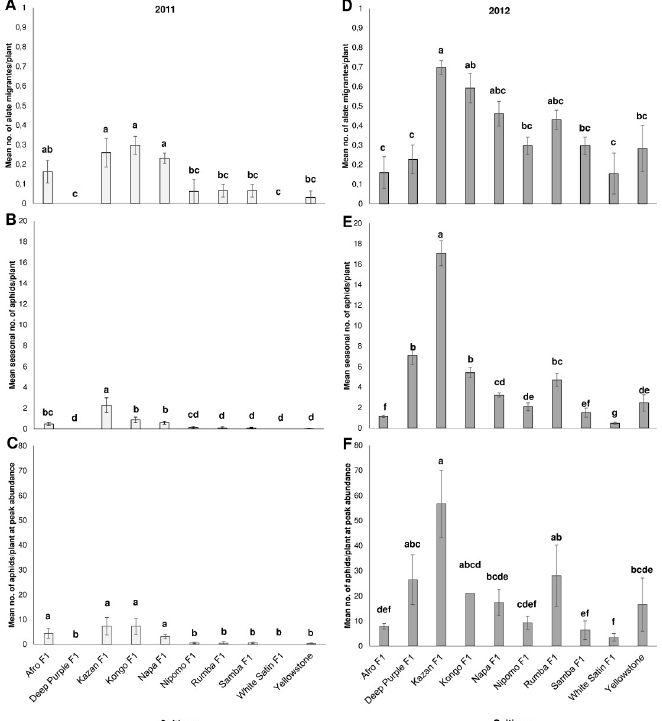
Fig 1. Mean Dysaphis crataegi abundance on carrot genotypes: (A, D) during the aphid migration period), (B, E) throughout the growing season and (C, F) at peak abundance. Means with the same letters on each bar are not significantly different (Duncan’s Multiple Range Test P < 0.05.